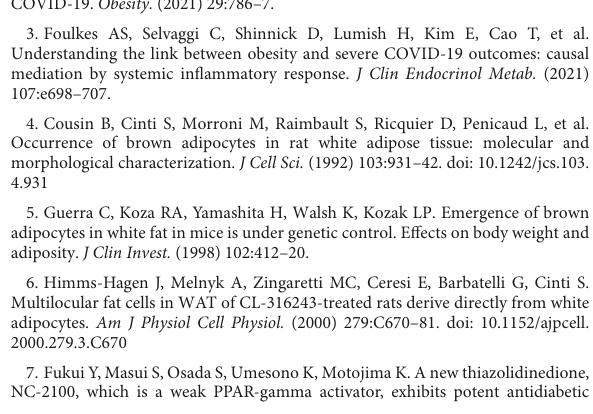
SUPPLEMENTARYFIGURE2 Naringenin increases protein expression of general differentiation markers and mitochondrial respiration in murine brown adipocytes. Murine brown pre-adipocytes were differentiated in the presence or absence of NAR (10 µ M) or ROSI (1 µ M). (A) After 6 days, protein expression of PPAR γ , FABP4, perilipin (PLIN), and the loading control ERK1/2 are shown (left panel). Bar graphs show the densitometry of each gene normalized to the loading control ERK1/2 (right